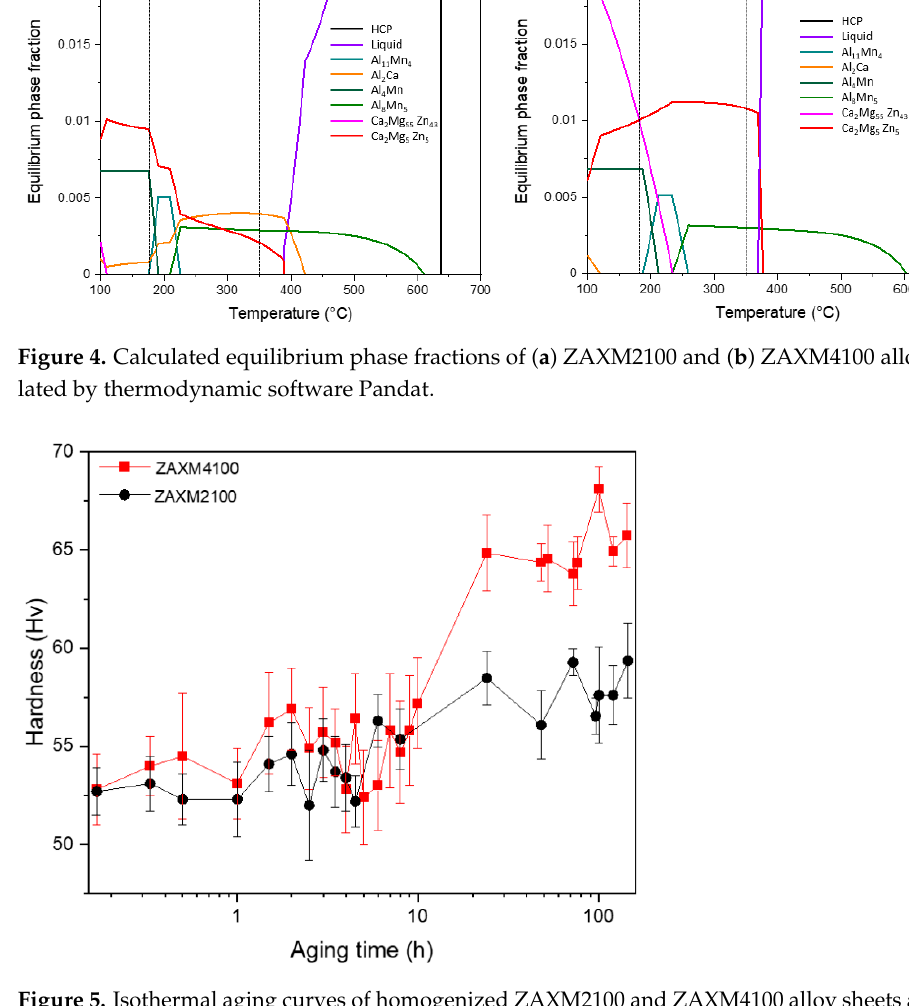
Figure 5. Isothermal aging curves of homogenized ZAXM2100 and ZAXM4100 alloy sheets at 180 °C.